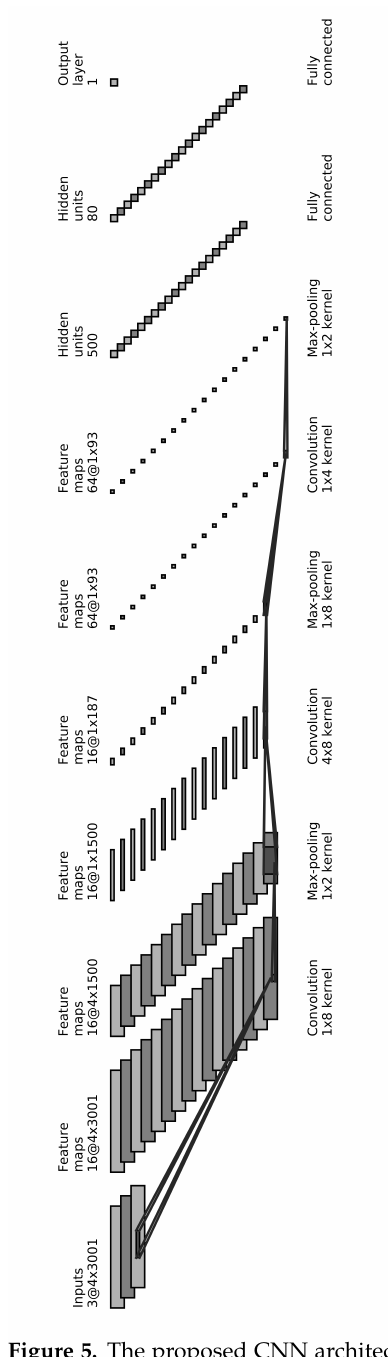
Figure 5. The proposed CNN architecture starting with 3 convolutional layers, each followed by a max-pooling layer. The output of the final pooling layer is flattened and passed into two fully connected layers before outputting the result: event (1) or noise